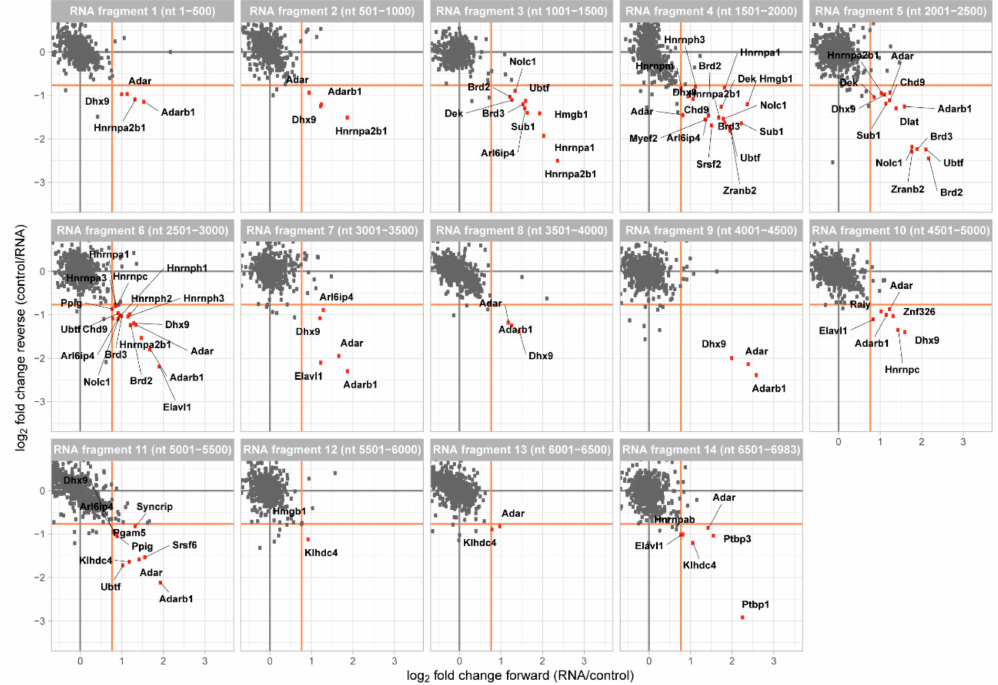
Figure 2. Two-dimensional interaction plot for each of the 14 RNA fragments. Fragments are numbered consecutive from 5 (cid:48) to 3 (cid:48) of murine Malat1 and their position within the lncRNA is indicated. Enriched proteins (fold change > 1.7, orange line) are marked in red and